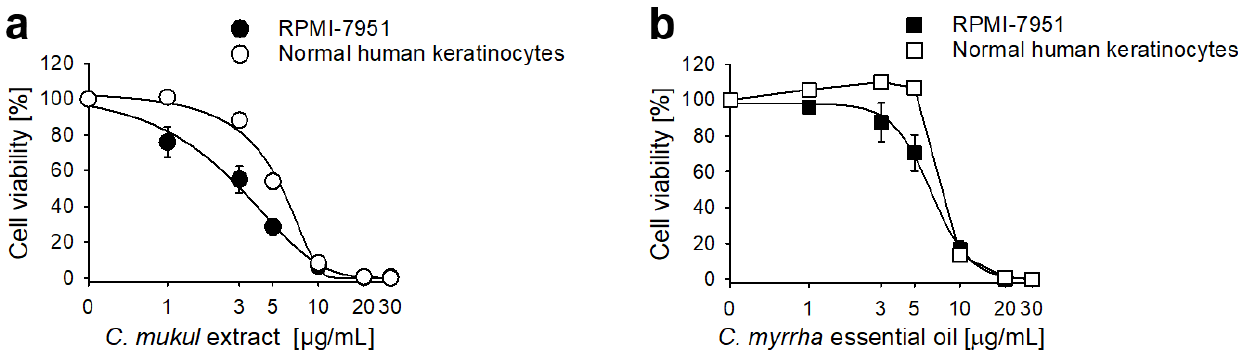
Figure 6. C. mukul extract and C. myrrha essential oil are more toxic to malignant melanoma cell line RPMI-7951 than to normal human keratinocytes. ( a ) C. mukul extract. ( b ) C. myrrha essential oil. Cell viability was analyzed by XTT assay in cells treated for, 72 h. All data were mean ± SEM of three biological samples, each analyzed in triplicates.